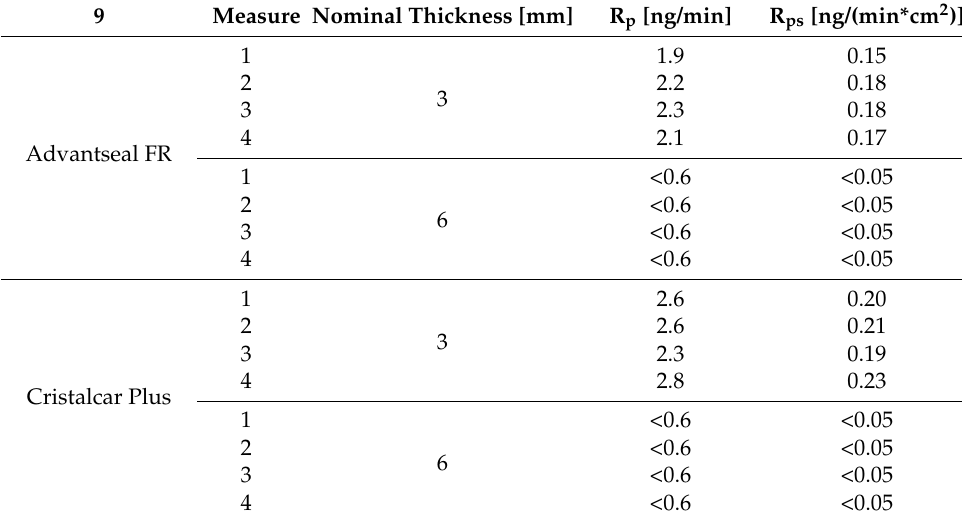
Table 2. Experimental results hydrogen permeability